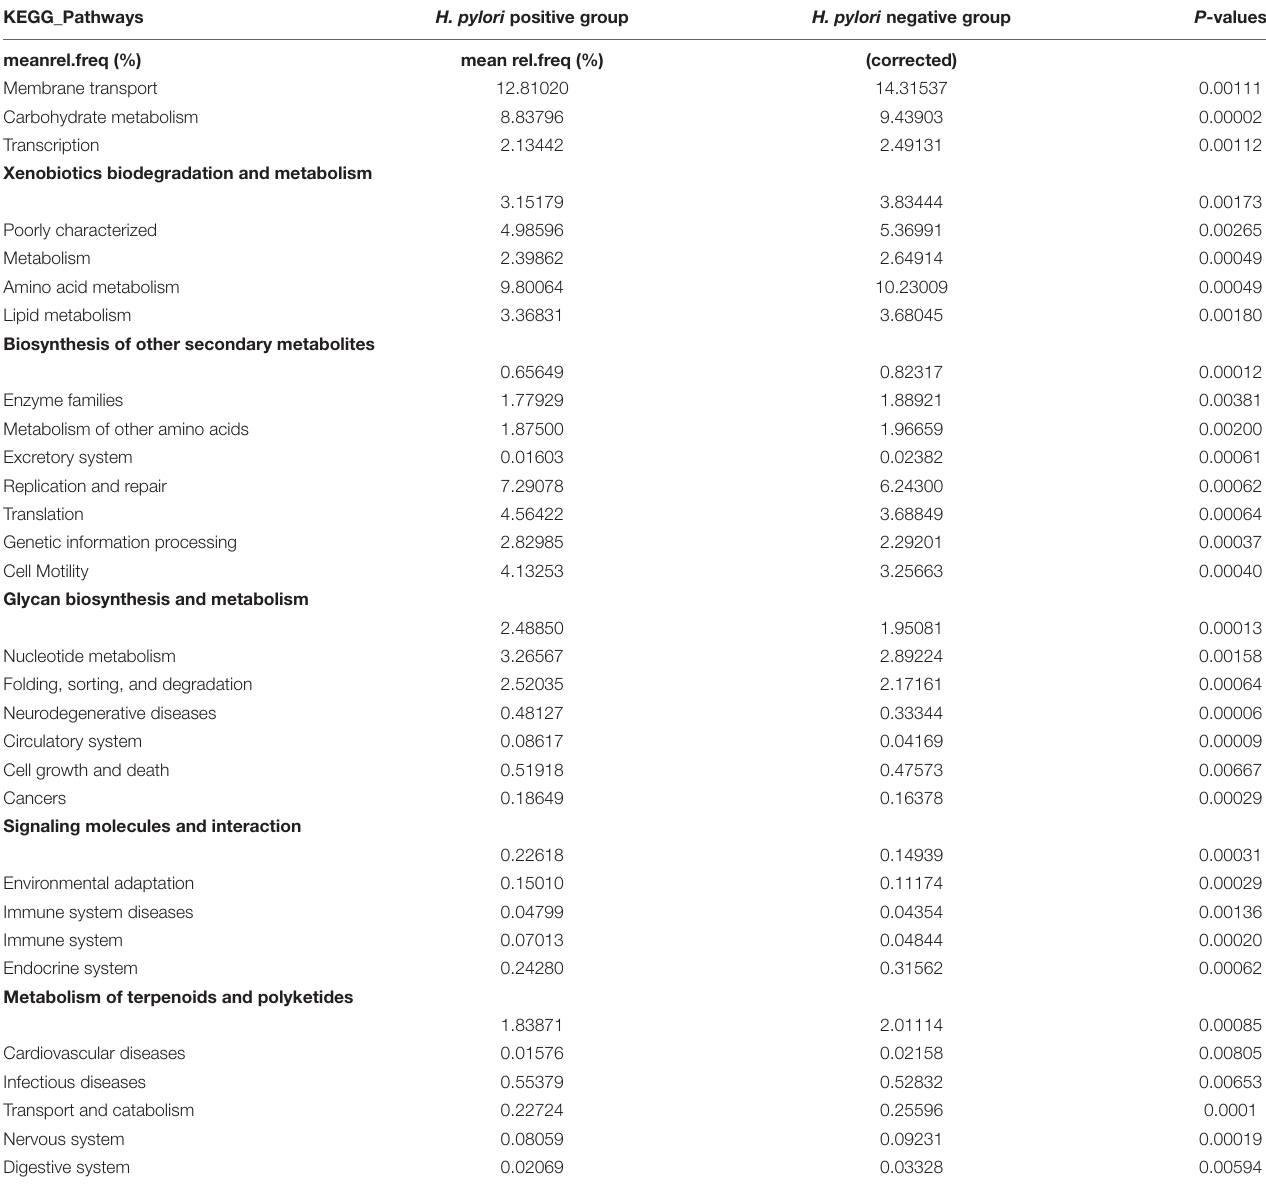
TABLE 3 | Predicted Kyoto Encyclopedia of Genes and Genome (KEGG) Pathways differentially abundant between H. pylori positive group and H. pylori negative group.